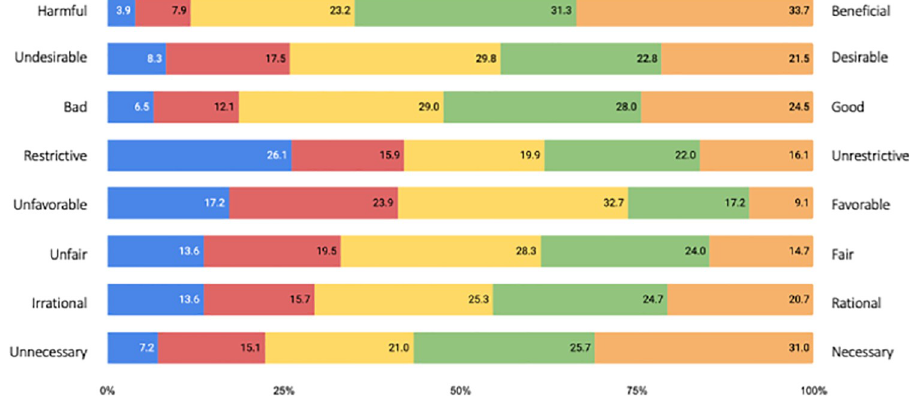
RQ4. A statistically significant regression equation was found ( F (8, 380) = 50.317, p < .001), with R 2 = .514 (adjusted R 2 = .504). Values of standardized beta coefficients are presented in Fig 2. Out of all factors included in the analysis, only severity of informal punishment (e.g., social media posts, appearances on television, or other mass media), perceived severity of the infec- tion, and perceived response efficacy were found to be significantly associated with compliance to the COVID-19 recommended preventive behavior. Altogether, 51 percent of variance can be explained by factors included in the research.